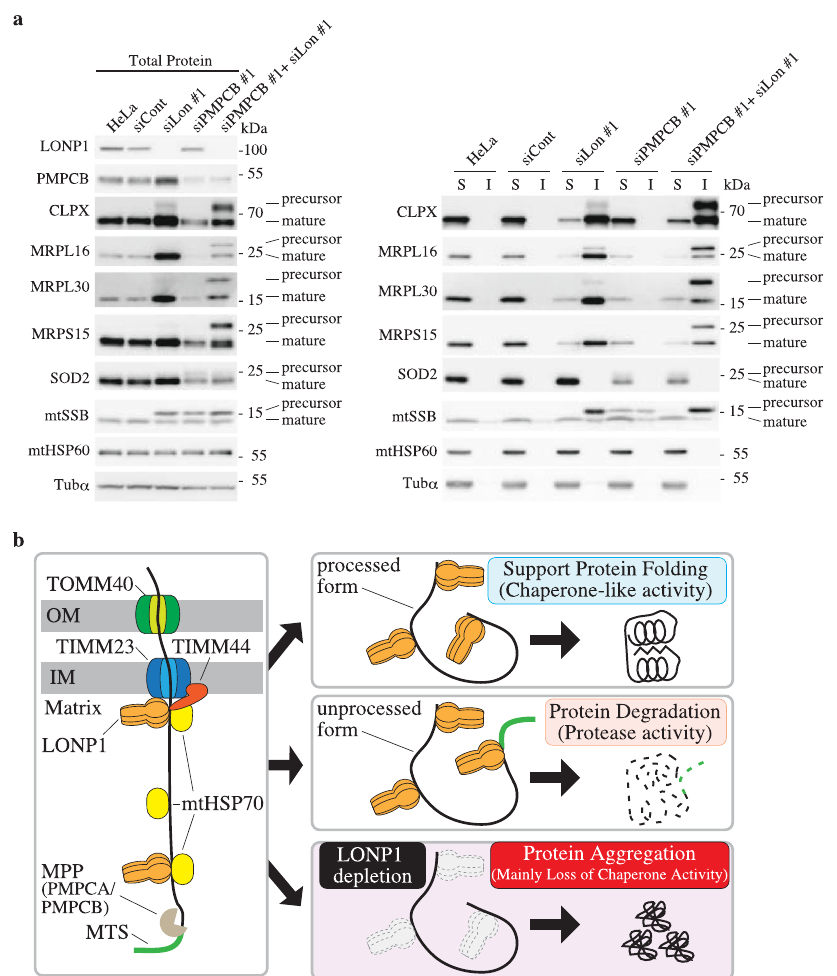
Fig. 7 LONP1 speci fi cally degrades some unprocessed mitochondrial proteins. a Analysis of proteins from HeLa cells treated with siRNAs. The cells were used for experiments 3 d after the second transfection, Left panel , immunoblot analysis of total proteins from cells was carried out as described in the legend to Fig. 1a. Right panel , immunoblot analysis of soluble (S) and insoluble (I) proteins in the knockdown cells was carried out as described in the legend to Supplementary Fig. S2. b Model of LONP1 activity toward imported proteins. Left panel , LONP1 associates with incoming proteins. Right panel , LONP1 assists folding and/or assembly of the imported proteins using its chaperone-like activity. Unprocessed imported proteins are degraded by LONP1. Imported proteins aggregate in the mitochondrial matrix of LONP1 knockdown cells or LONP1 dominant negative